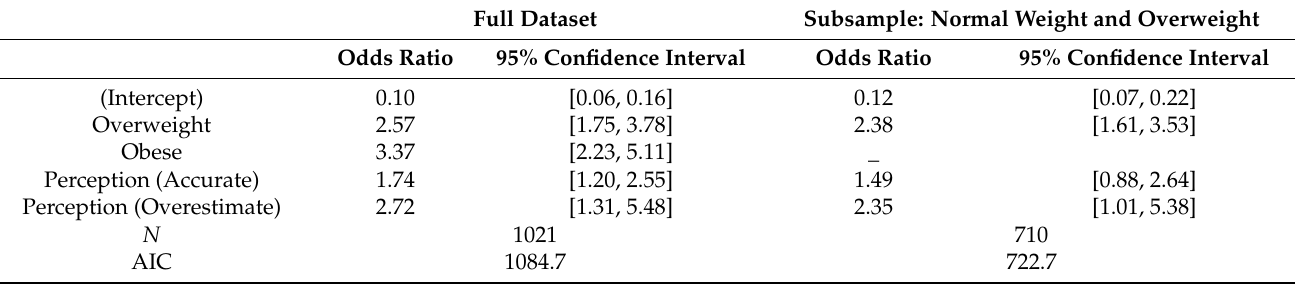
Table 4. Relationship between weight status and dieting. Full